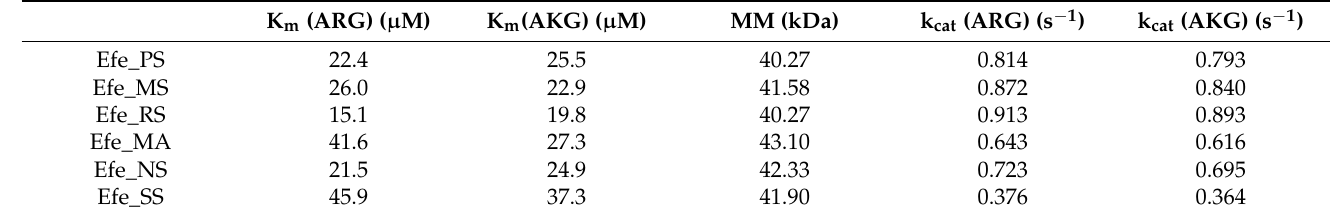
Table 1. Summary of fundamental kinetic parameters, K m , k cat , of six purified ethylene forming enzymes.